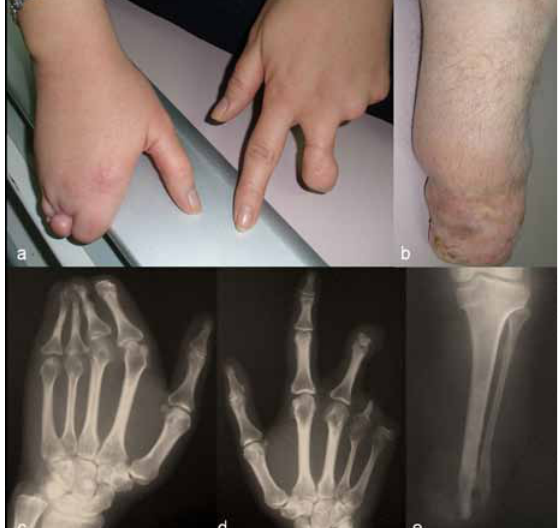
Figure 1. The photographs (a), (b) and the anteroposterior radio- graphs (c), (d), (e) show upper and lower limb